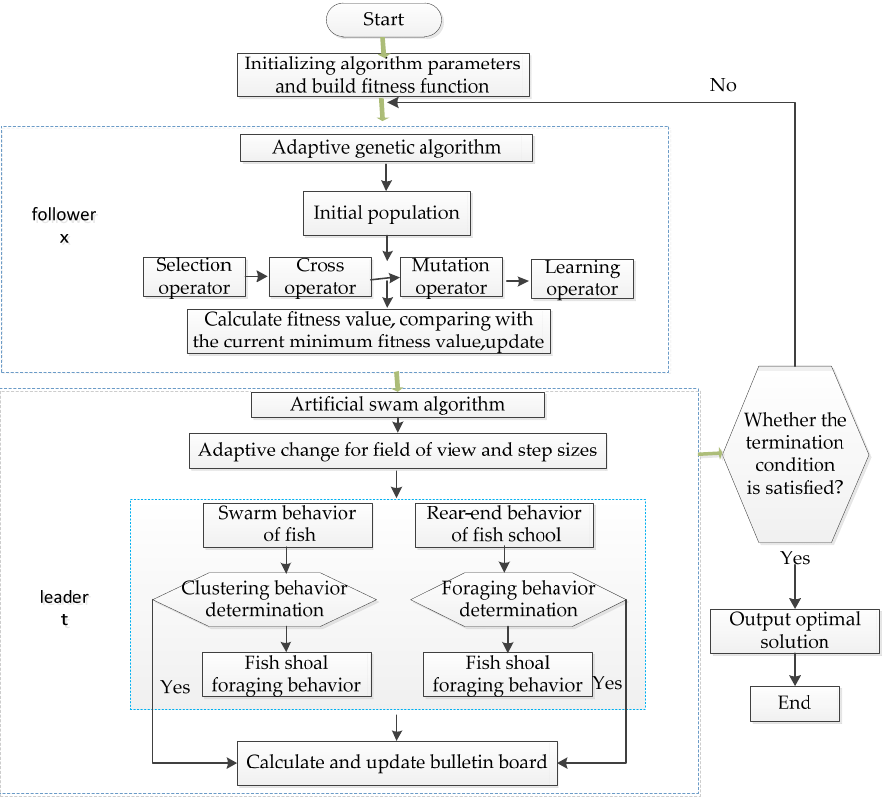
Figure 3. Flowchart of an adaptive hybrid artificial fish swarm genetic algorithm.